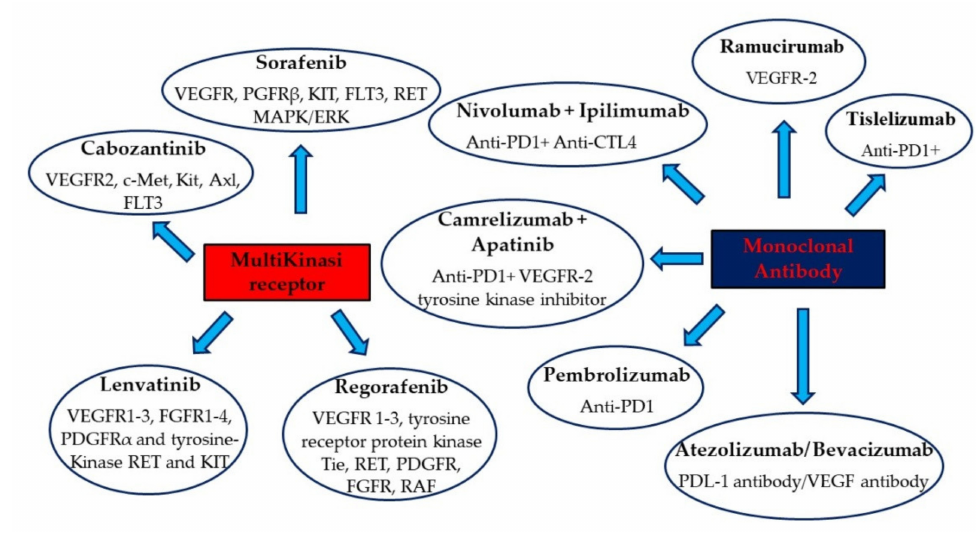
Figure 1. FDA-approved and main drugs from ongoing trials for